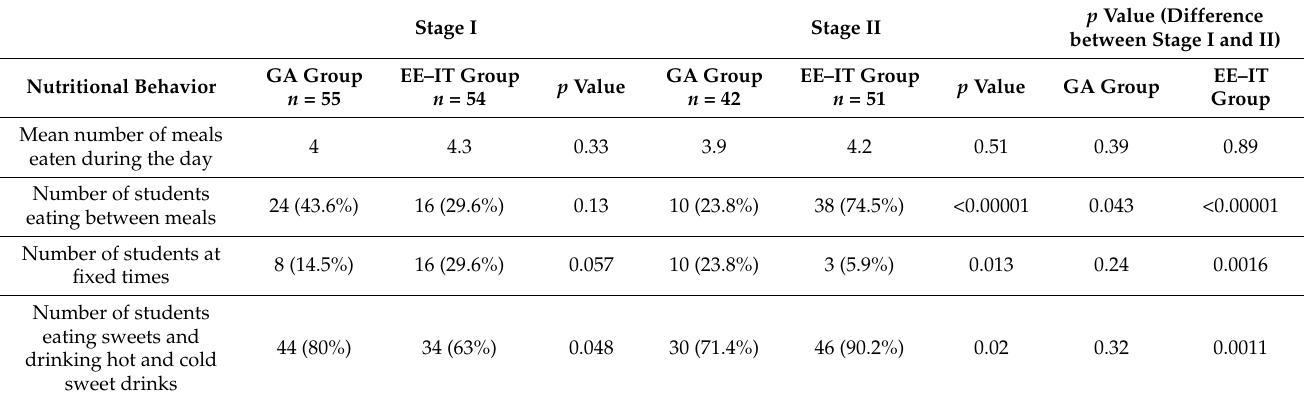
Table 4. Nutritional behavior of the GA and EE–IT students in the first and second stages of the study. Stage I Stage